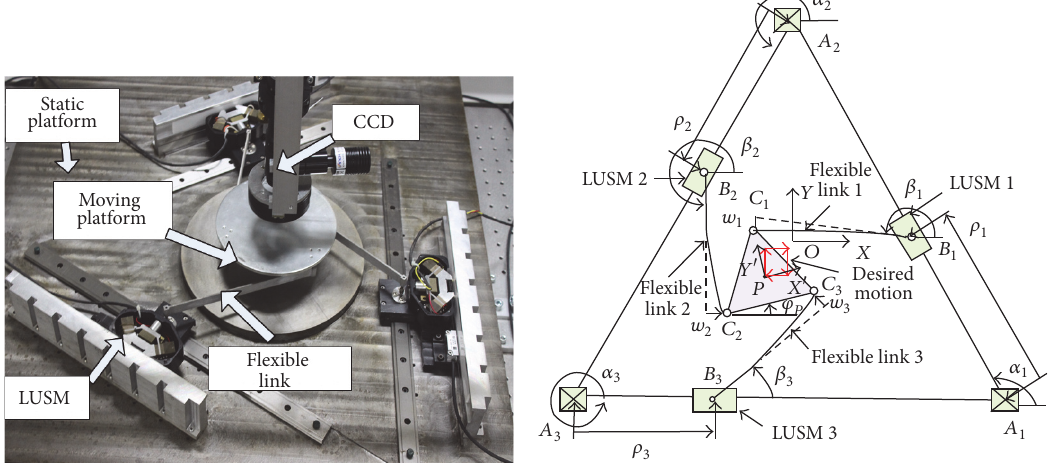
Figure 1: The prototype and mathematical model of the 3-PRR parallel